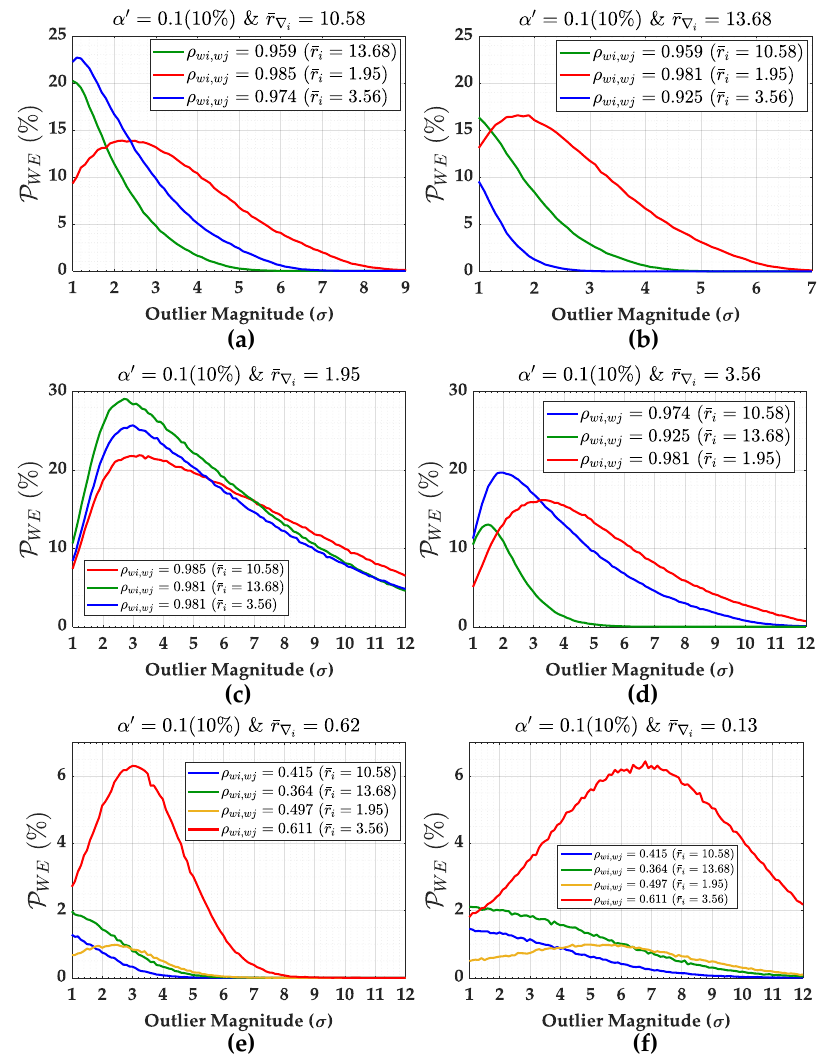
Figure 18. Individual contribution of each measurement to the overall wrong exclusion probability ( P WE ) for network ( b ) and for α (cid:48) = 0.1. ( a ) Individual contribution to P WE for ∆ h 1 . ( b )